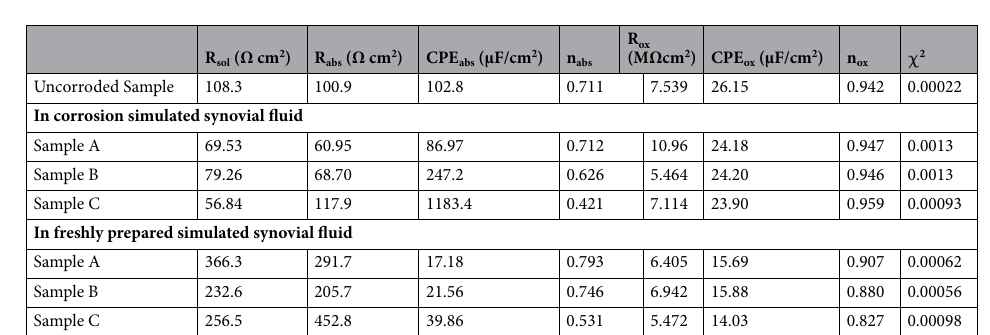
Figure 8. EIS equivalent circuit model fitting example graphs. EIS equivalent circuit modeling for samples analyzed as a symmetric cell in freshly prepared model synovial fluid. ( a ) Equivalent circuit model. R sol , solution resistance/solution interaction resistance with absorption layer, R abs , absorption/outer layer resistance, CPE abs , constant phase element of the absorption/outer layer, R ox , oxide/inner layer resistance, CPE ox , constant phase element of the oxide/inner layer. ( b ) Comparison of positive real impedance (x-axis) and negative imaginary impedance (y-axis). ( c ) Total magnitude of impedance (y-axis) is plotted against frequency (x-axis). ( d ) Phase angle (y-axis) is plotted against frequency (x-axis).